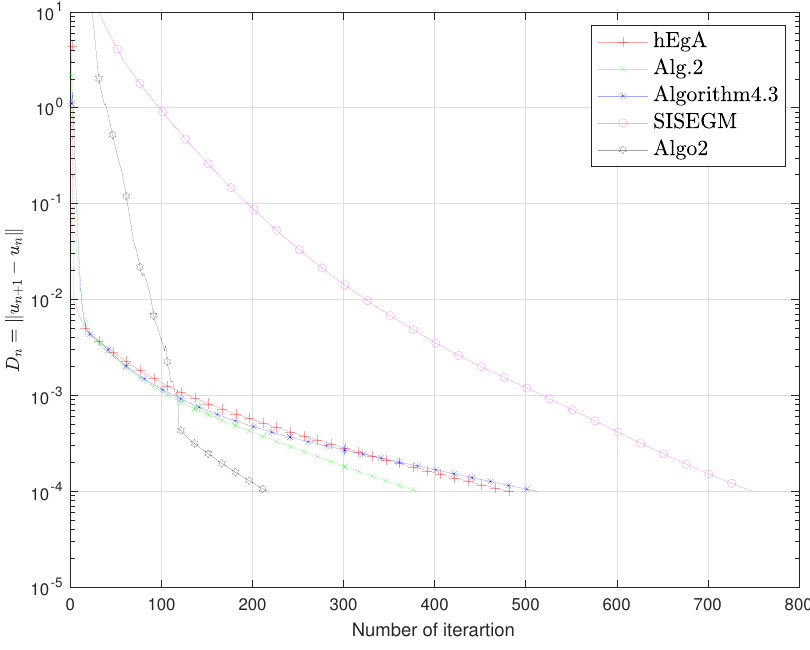
Figure 11. Example 1 in R 5 : Numbers of iterations are 482, 382, 513, 749, 216